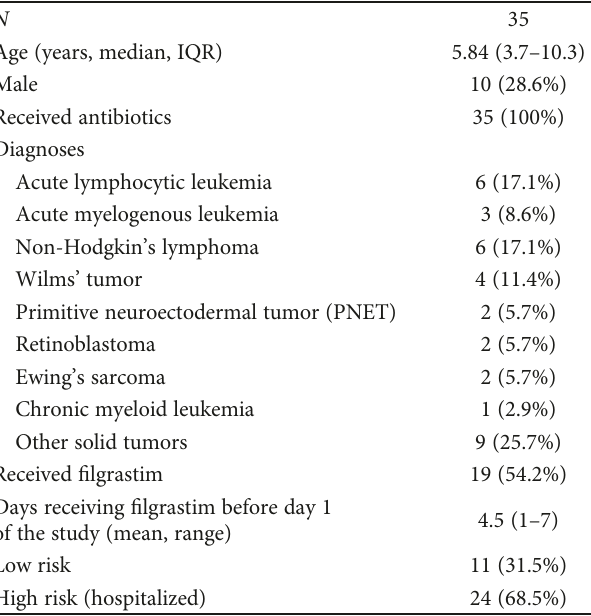
Table 2: General data ( N , %). IQR: interquartile